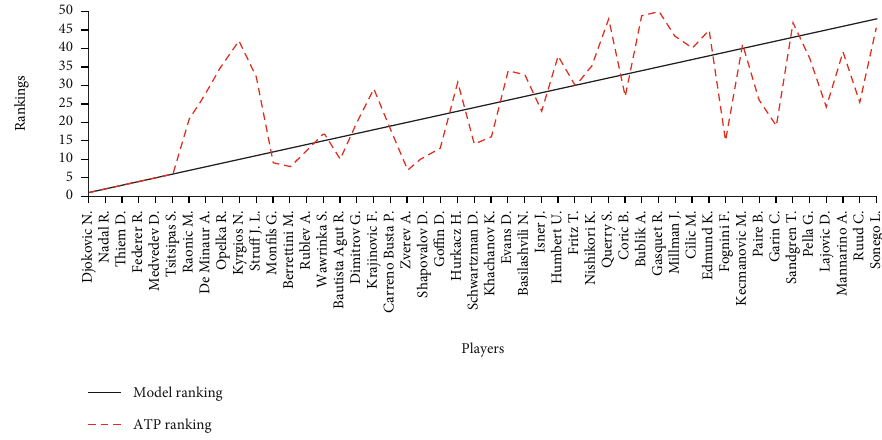
Figure 4: Comparison of model ranking with ATP ranking for top 50 tennis players on hard court.